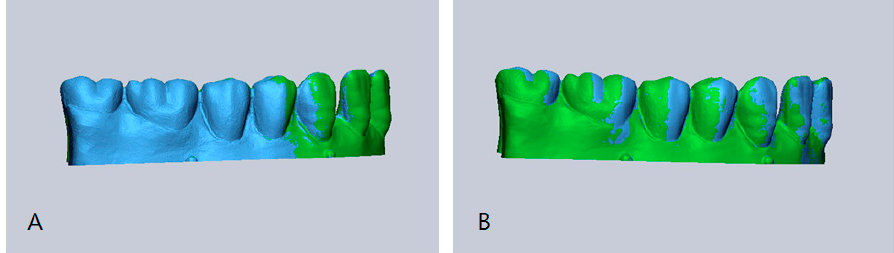
Figure 11. Deviation occurs in the posterior area after superimposition. Blue: data from the intraoral scanners, Trios ® and iTero ® ; Green: data from the reference scanner. ( A ) Represents iTero ® : more blue than green in the posterior region. ( B ) Represents Trios ® : mixed blue and green in the posterior region. Intermolar width provides important information in data-based treatment planning and construction of orthodontic appliances. Our results indicated that due to a large deviation in intermolar width (the highest deviation value was 0.7 mm), iTero ® may not be suitable for making orthodontic appliances for the mandibular teeth with large anterior interdental spaces. Such an undesired phenomenon with iTero ® parallels the findings in Sebastian et al. [17], where horizontal expansion of molar region was observed during the process of image integration through the software within the